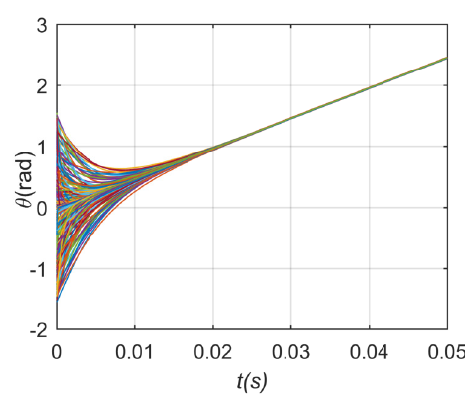
Figure 17. Phase stabilization process of directed network in case